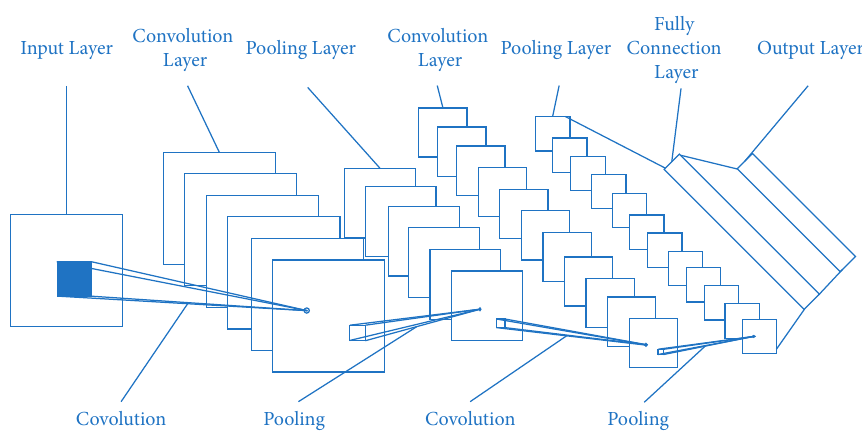
Figure 1: The model of the convolution neural